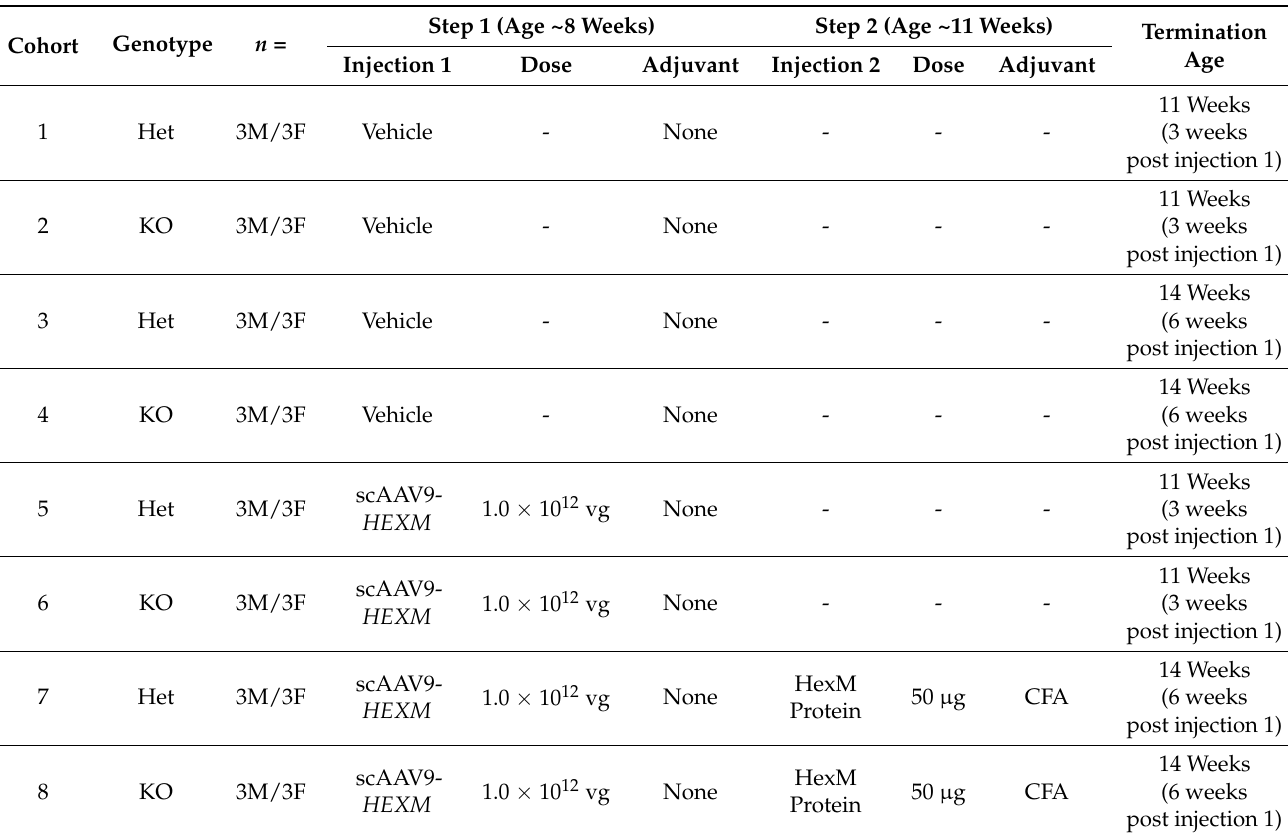
Table 1. Study design for TSD mice, including genotype, number of mice, injection, and termination time points.